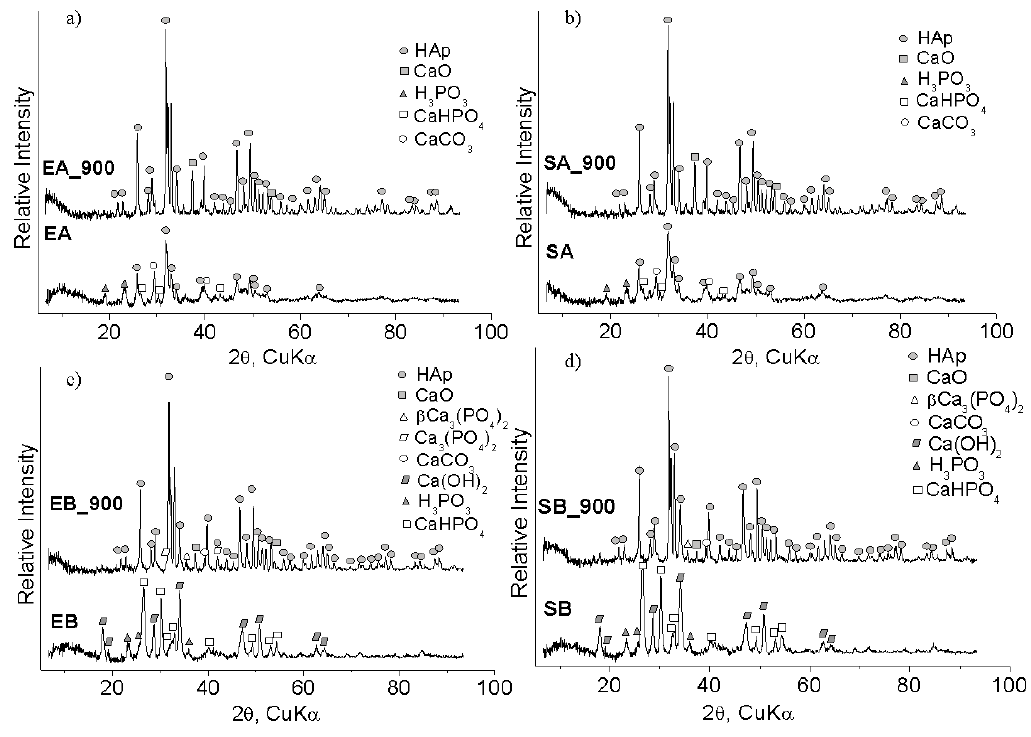
Figure 3. X-ray diffractograms of the samples: (a) EA and EA_900, (b) SA and SA_900, (c) EB and EB_900, (d) SB and SB_900. trace elements of eggshell and seashell.